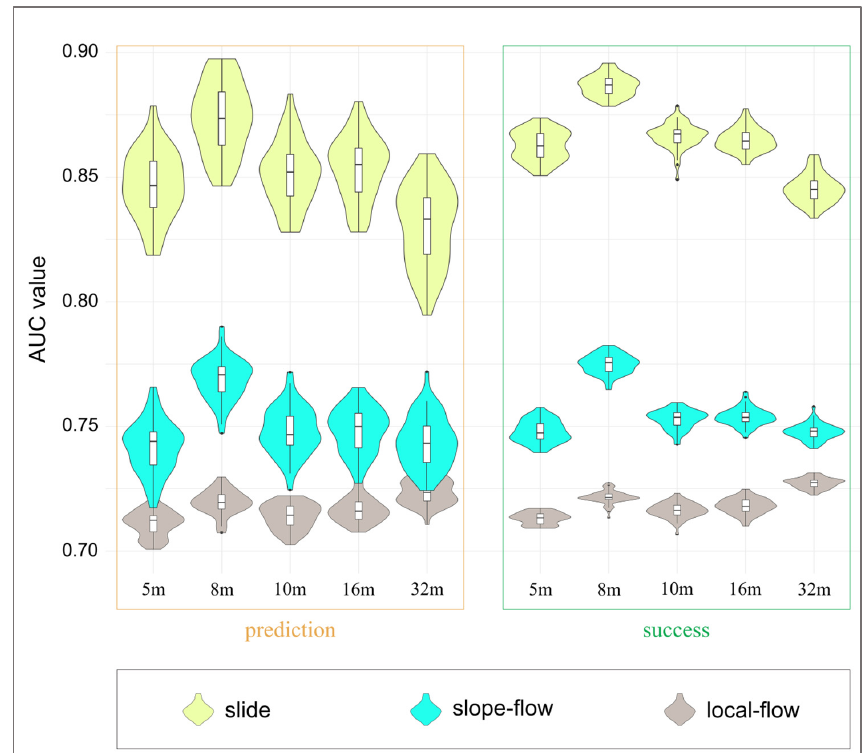
Figure 3. AUC values of replicates of each modelling procedure with respect to the three different landslide typologies, both in prediction and in success validation.